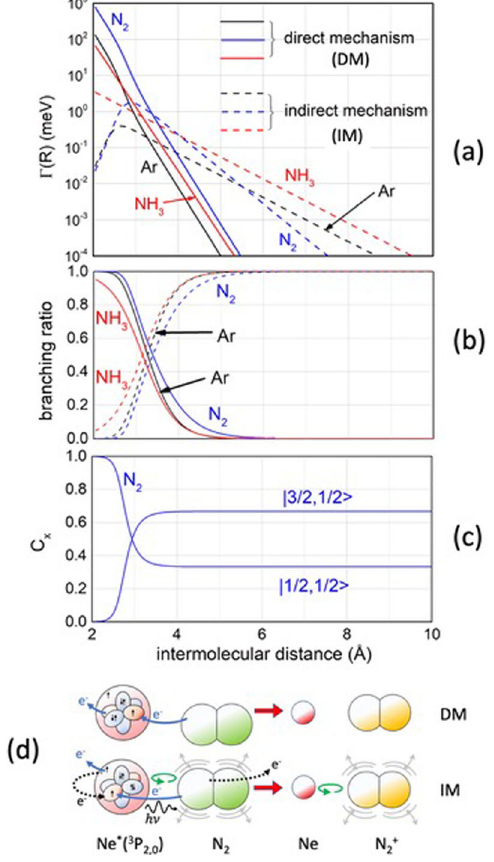
Fig. 4 The role of DM and IM mechanisms on the topology of Ne * + Ar, N 2 , NH 3 stereo-dynamics. a Comparison between the different dependence on intermolecular distance R of Γ components determining direct mechanism (DM) and indirect mechanism (IM) in the selected channels of CHEMI. The overall ionization width for each investigated system is approximately given by the sum of the two correlated Γ -functions plotted 35 .